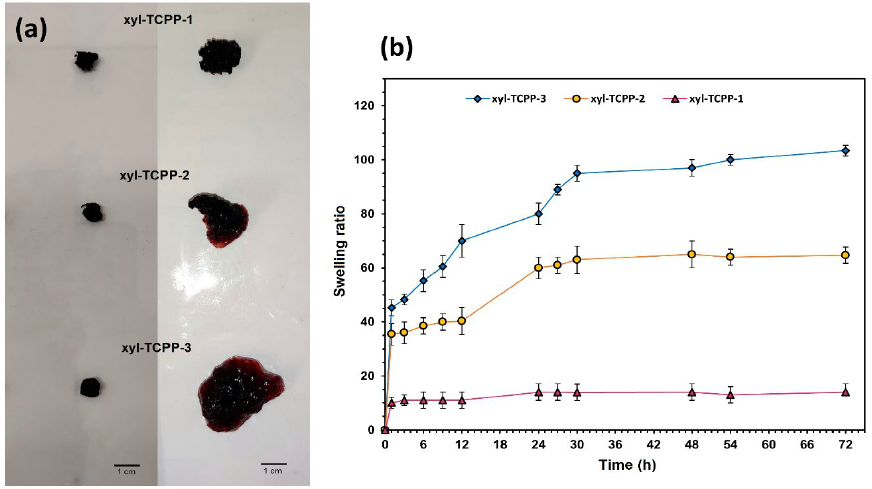
Figure 4. ( a ): freeze-dried xyl-TCPP-1, xyl-TCPP-2, and xyl-TCPP-3, left, before swelling and right, after 72 h immersion in water; ( b ): time course of swelling ratios of xyl-TCPP-1, xyl-TCPP-2, and xyl-TCPP-3 in distilled water.